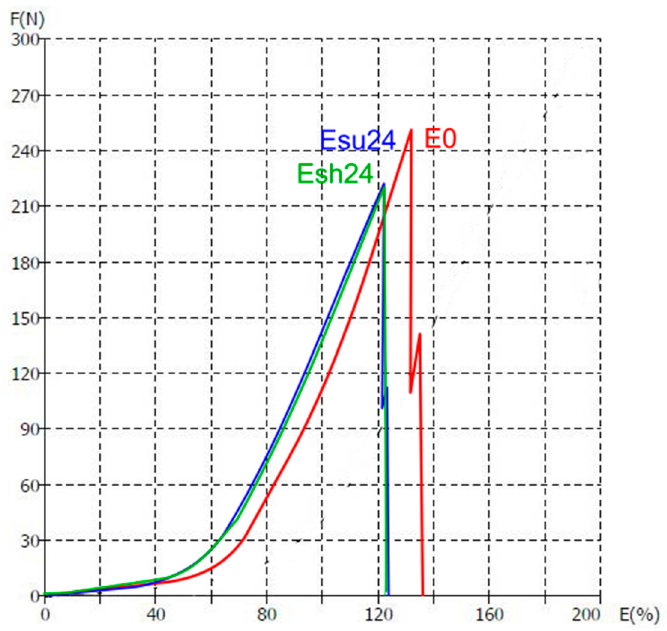
Figure 9. The F/E curves for the specimen F1 in the conditions E0, Esu24, and